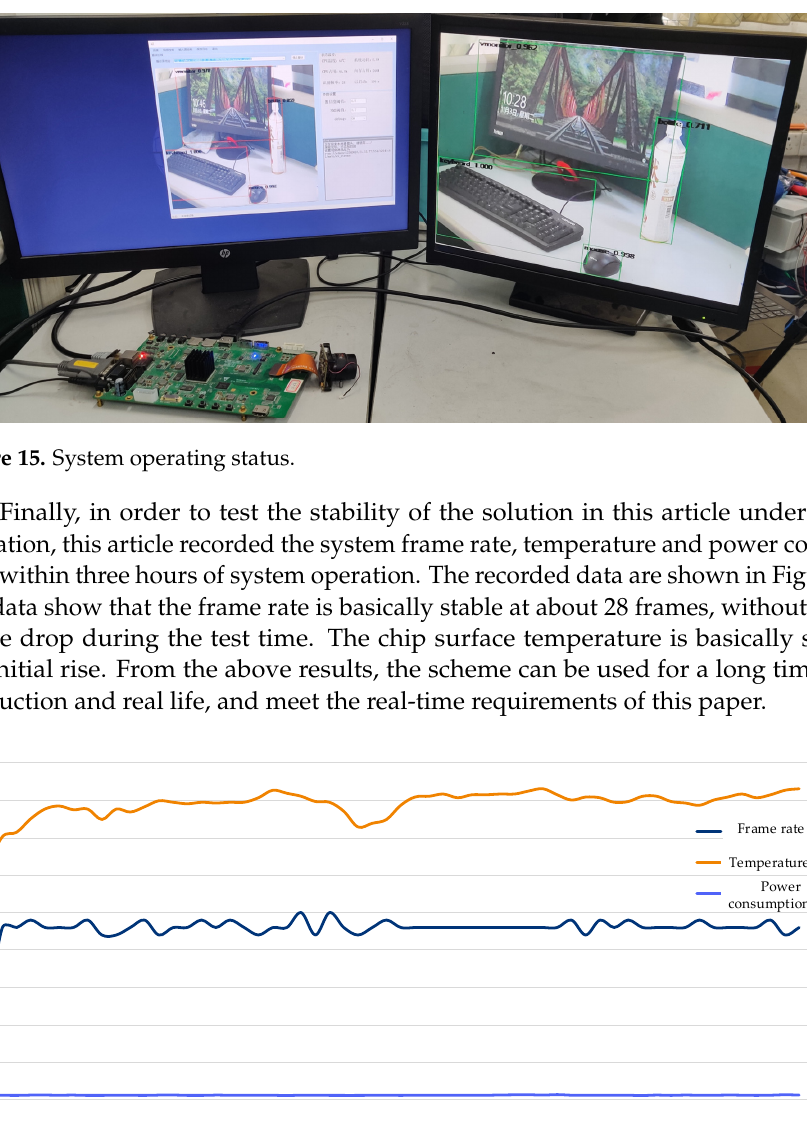
Figure 16. System stability test results .